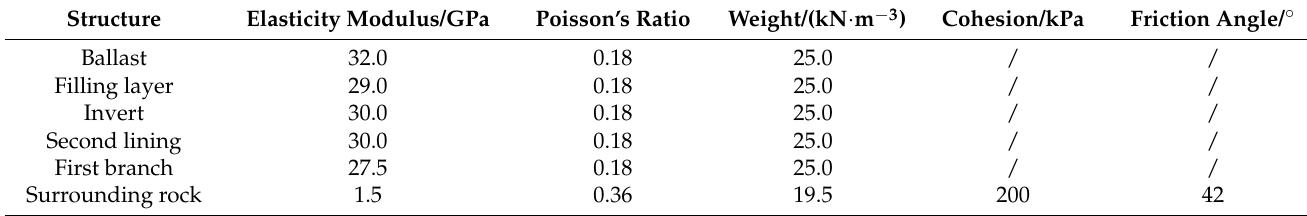
Table 7. Basic mechanical parameters of concrete and surrounding rock.